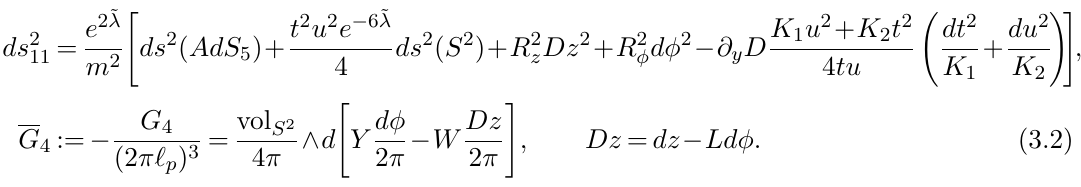
Figure 1. Cases that yield a rectangular domain in the ( t, u ) plane, as determined by the inequalities (2.21) option (a). In all cases, 0 < t the φ circle in the base of the Dz fibration (3.2) shrinks smoothly along that component of the boundary of the allowed region. Similarly, the label S 2 indicates a smooth shrinking of the S 2 . The label sM5 stands for smeared M5-brane sources. Case III is understood to include the limiting case t 1 u 2 − u 1 t 2 = 0 , in which the lines defined by f 1 and f 2 coincide, and touch the lower right corner of the shaded